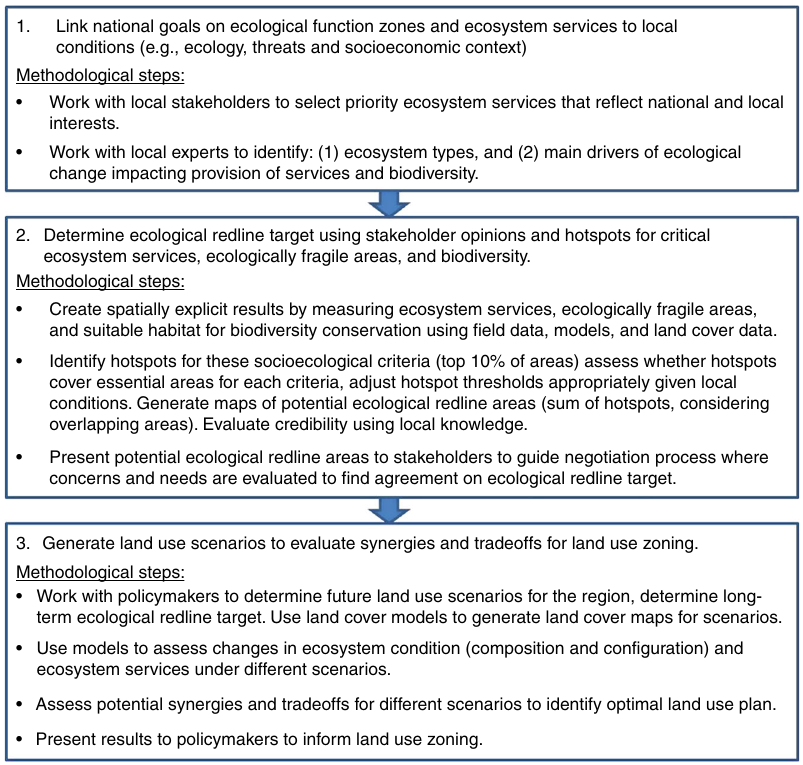
Fig. 2 Methodological framework to conduct an ecosystem services assessment to determine ecological redline areas in